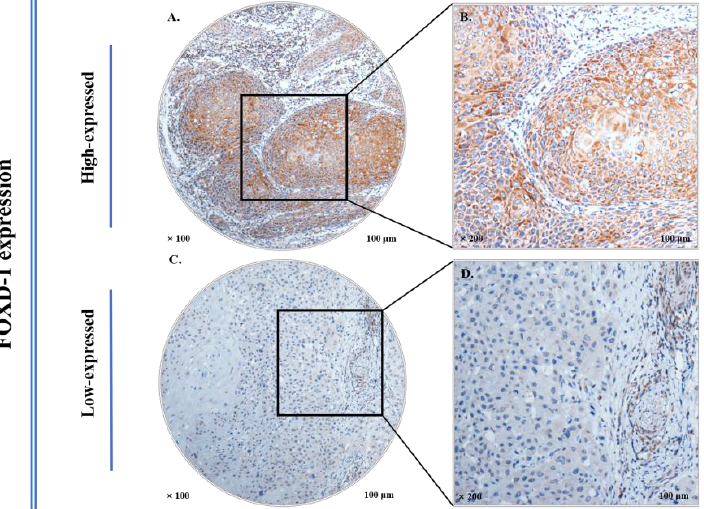
Figure 2. Representative immunohistochemical staining of FOXD1 in HNSCC TMAs. High expression of FOXD1 in 100× ( A ) and 200× ( B ). Low expression of FOXD1 in 100× ( C ) and 200× ( D ).